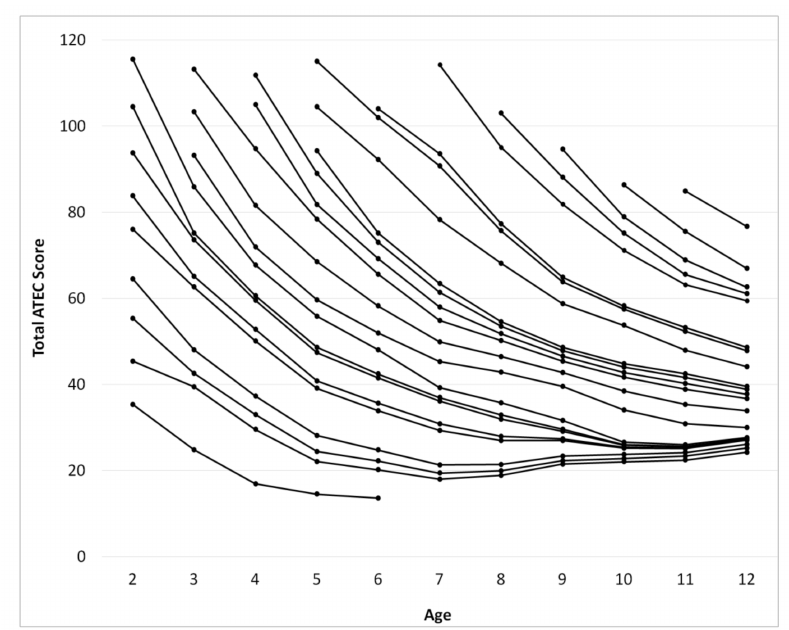
Figure 2. Continuous changes of the total ATEC score over age calculated from pair-wise observations using the “relay” procedure. To find out a typical trajectory for a child, (1) find the point on the graph corresponding to the child’s current age and score; (2) locate the trajectory line under the point; (3) follow the trajectory line to read the typical ATEC total score at any age. For example, a typical child with ATEC total score of 116 at age 2 is expected to reduce ATEC total score to 86 at age 3; 68 at age 4; 56 at age 5; 48 at age 6; 39 at age 7; 36 at age 8; 32 at age 9; 27 at age 10; 26 at age 11; and 28 at age